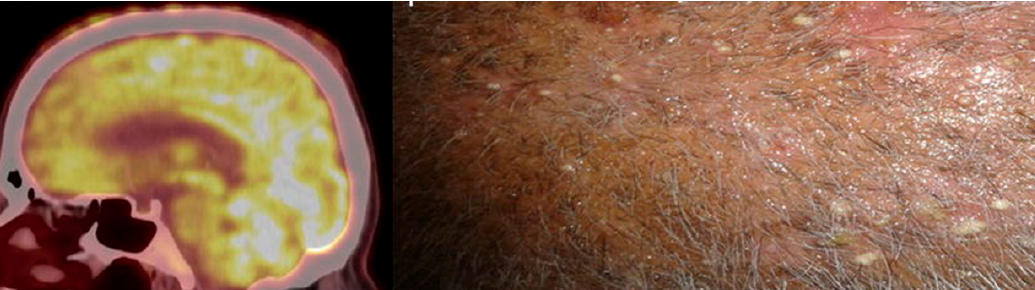
Figure 4. Cutaneous toxicity in a patient with metastatic lung cancer treated with erlotinib. A fused sagittal FDG PET-CT image of the skull shows multiple focal areas of FDG uptake in the scalp ( left panel ) that corresponded to pustular nodules, as seen on the photograph ( right panel ). (Used with permission from [84]).